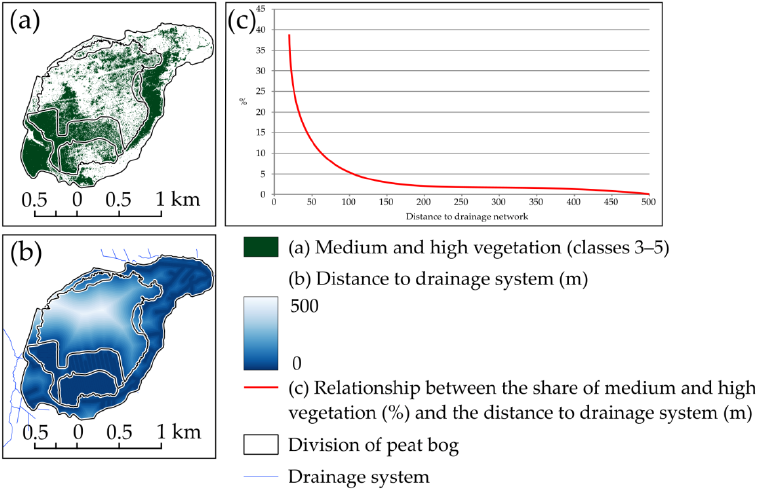
Figure 6. ( c ) Relationship between the spatial distribution of medium and high vegetation areas ( a ) and distance to drainage system ( b ). and distance to drainage system ( b